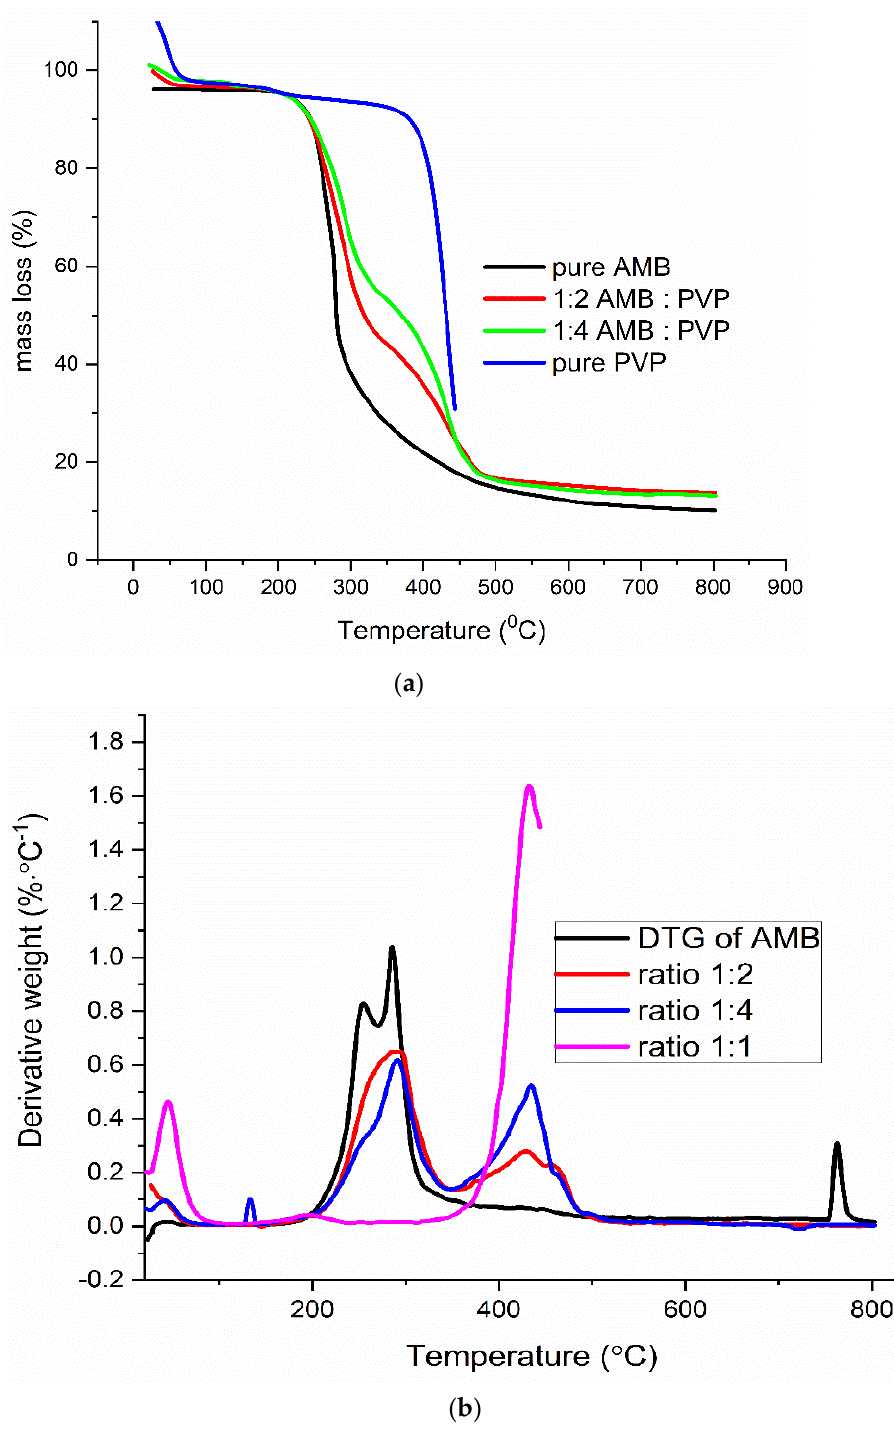
Figure A4. ( a,b )TG/DTG curves of AMB/PVP mixtures. Figure A4. ( a , b )TG/DTG curves of AMB/PVP